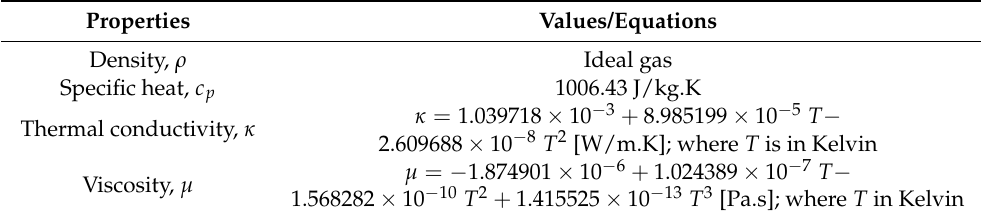
Table 1. The properties of air used in the CFD